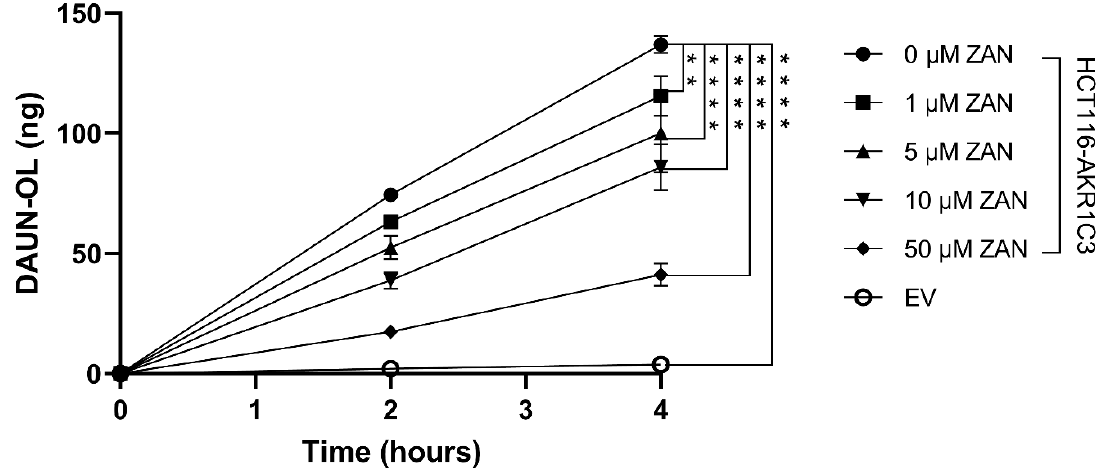
Figure 2. Zanubrutinib (ZAN) inhibits AKR1C3-mediated daunorubicin (DAUN) metabolism in intact cells. Transfected HCT116 cells were incubated with DAUN (1 µM) in combination with ZAN (1, 5, 10 and 50 µM) or its vehicle dimethyl sulfoxide (DMSO) for 2 and 4 h. DAUN-OL was then extracted and its amount was analysed by ultra-high-performance liquid chromatography (UHPLC). Data were evaluated with one-way analysis of variance (ANOVA), followed by Dunnett’s post hoc test. ** p < 0.01 and **** p < 0.0001 compared to DMSO vehicle control. The values are expressed as mean ± standard deviation (SD) from three independent experiments.